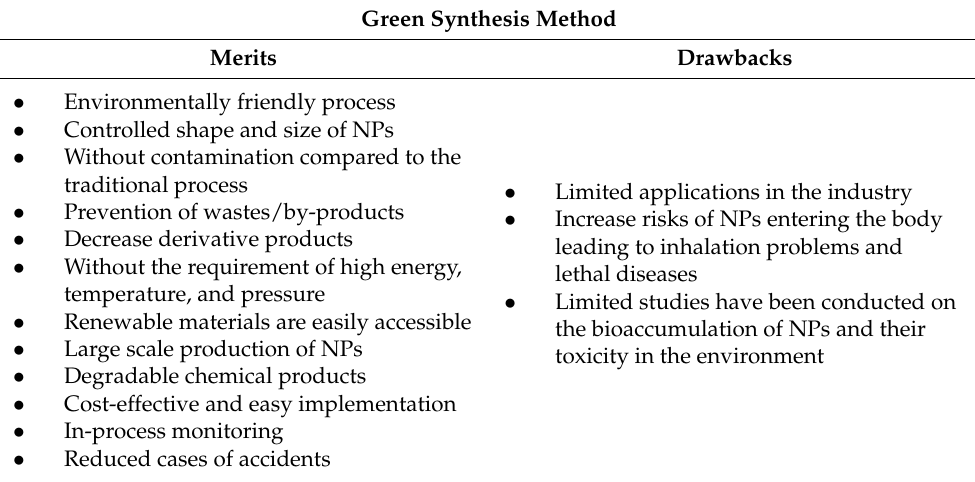
Table 1. Advantages and disadvantages of the green synthesis method. Elaboration from Ref. [43].